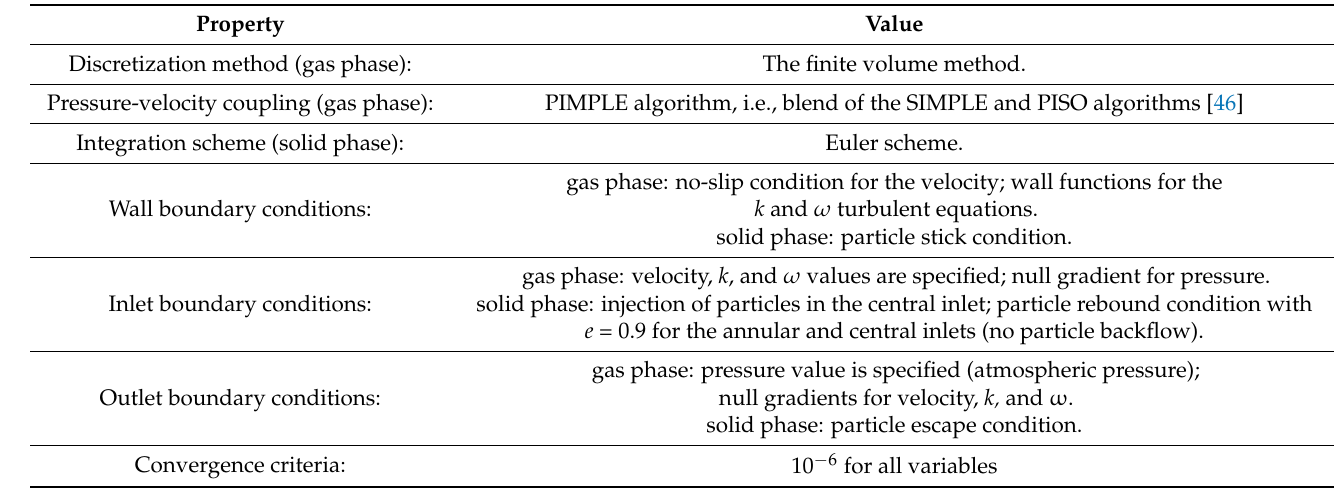
Table 3. Numerical methods and boundary conditions for the Euler-Lagrange simulations.